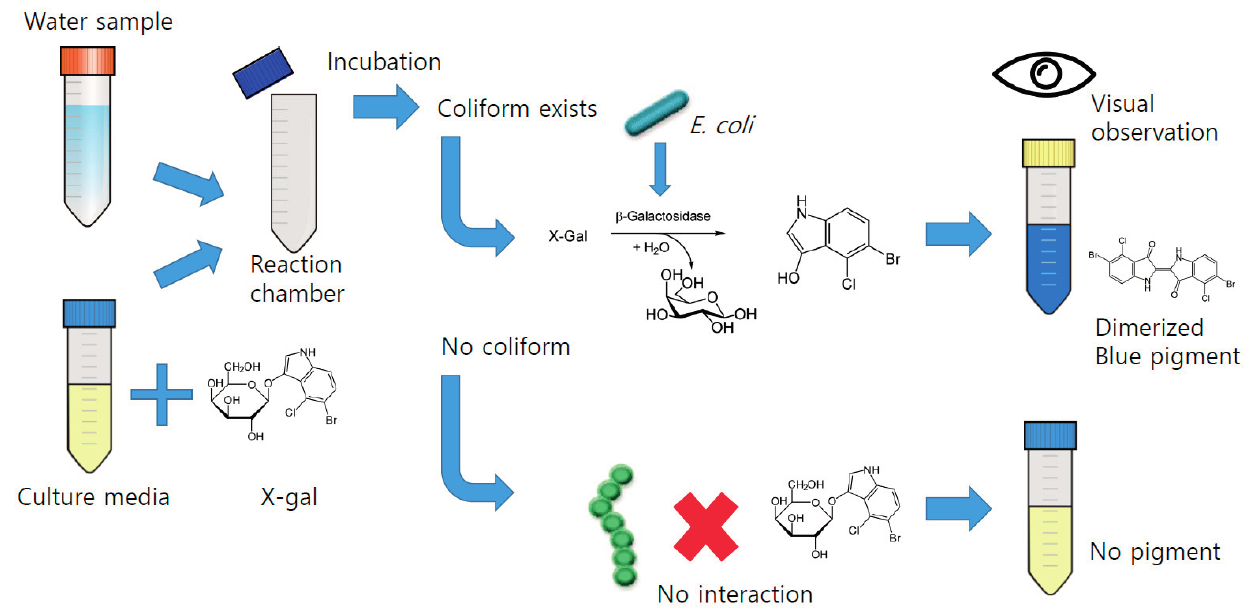
Figure 1. Process of chromogenic enzyme substrate